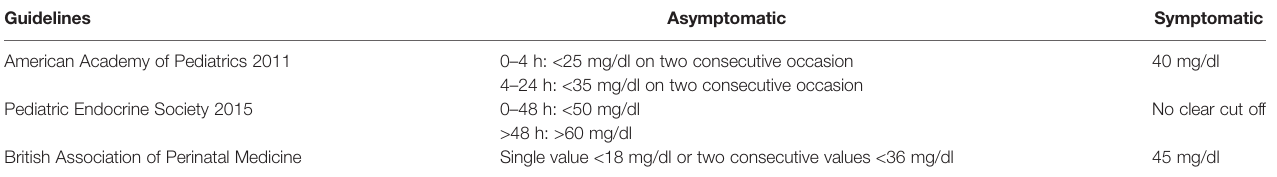
TABLE 2 | Neonatal HY Cut Off needing for intervention according with AAP, PES, BAPM.